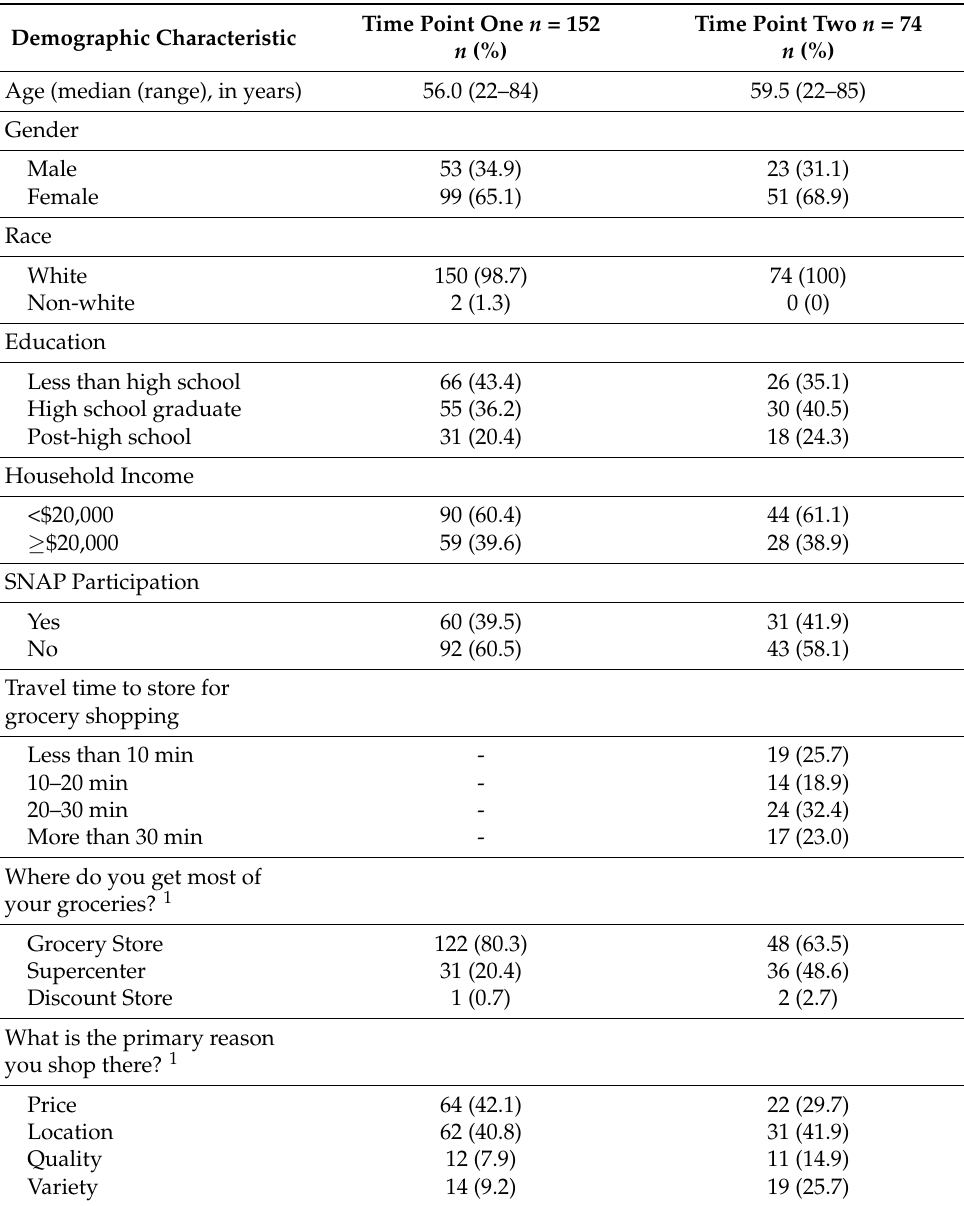
Table 1. Demographic characteristics among the sampled cohort participants between time point one and time point